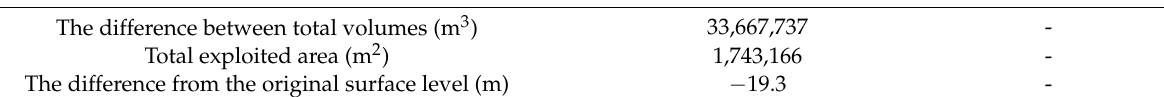
Comparison with the Original Surface